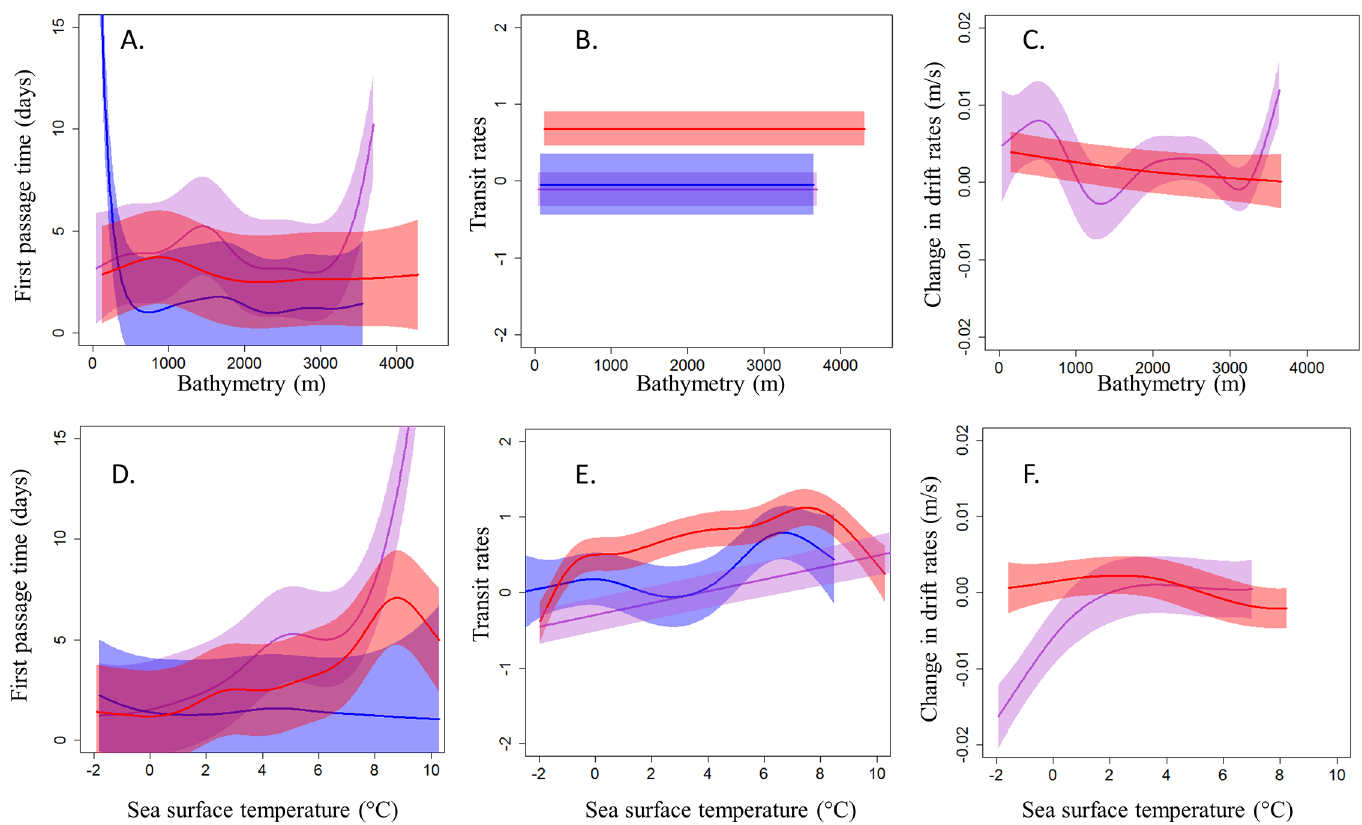
Fig 4. Effect of bathymetry and SST on foraging indexes of hooded seals using (A) first passage time (days), (B) vertical transit rates when diving PCA derived combination of ascent and descent rates, no unit), and (C) change in drift rates (m/s), for pups (purple), adult females (red) and adult males (blue) during the post-breeding season. Fitted estimates from the best models (solid curves) are representedalong with the CIs (polygons) calculatedfrom the variance–covariancematrices of the random effect of the fitted models.